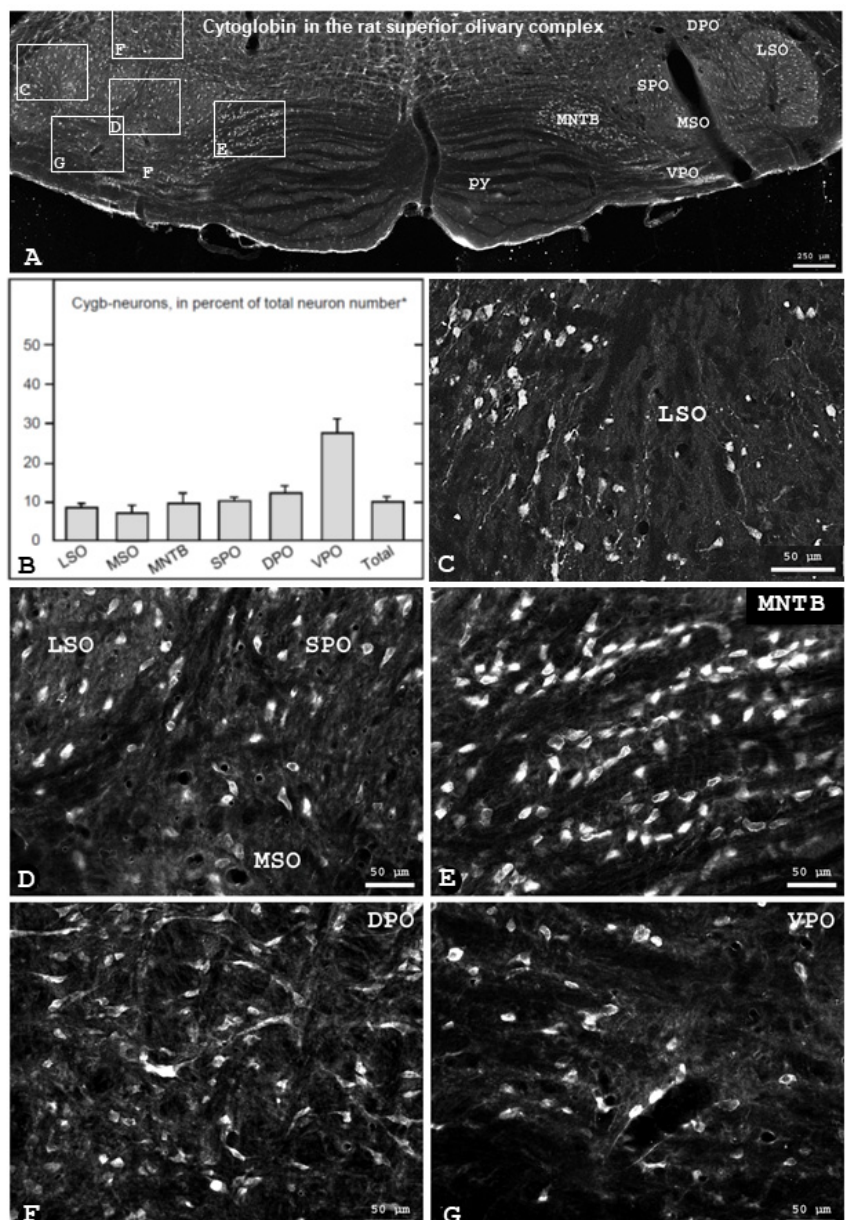
Figure 1. Cytoglobin (Cygb) protein distribution in a frontal section of the rat superior olivary complex (SOC). ( A ) Overview of Cygb-immunofluorescence in the bilateral SOC, taken from an intermediate section of the brainstem, demonstrating labeled neurons in all SOC regions. ( B ) depicts the numbers of Cygb-neurons in percent of the total neuron number for SOC regions (mean ± SD, n = 5), * taken from [25]. ( C ) shows the LSO in a section of the caudal SOC, demonstrating labeled spindle-shaped neurons and their processes oriented in dorsoventral direction. Higher magnifications from the left SOC shown in A demonstrate immunopositive neuronal perikarya in LSO, SPO, MSO ( D ), MNTB ( E ), DPO ( F ) and VPO ( G ) . Orientation in each section is medial left, dorsal up. Abbreviations: see list.